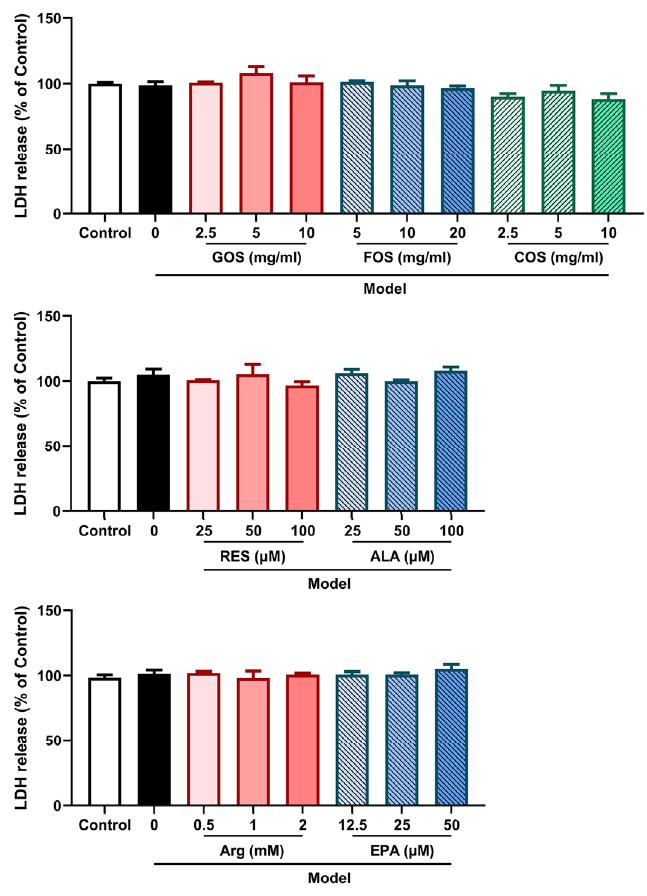
Figure 1. LDH release of Caco-2/HT-29 cell monolayers pre-incubated with GOS, FOS, COS ( A ), RES, ALA ( B ), arginine, and EPA ( C ) for 48 h then exposed to 2 h of hypoxia and heat treatment. LDH release into supernatants was assayed using a LDH assay. All values were presented as means ± SEM (N = 3, n = 2 (GOS, FOS, COS group) and n = 3 (all other groups)). Statistical differences were analyzed by two ‐ way ANOVA followed by the Bonferroni’s multiple comparison test. LDH, lactate dehydrogenase; GOS, galacto ‐ oligosaccharides; FOS, fructo ‐ oligosaccharides; COS, chitosan oligo ‐ saccharides; ALA, α‐ lipoic acid; RES, resveratrol; Arg, l ‐ arginine; EPA, eicosapentaenoic acid. The detailed raw OD data are listed in Table S1.